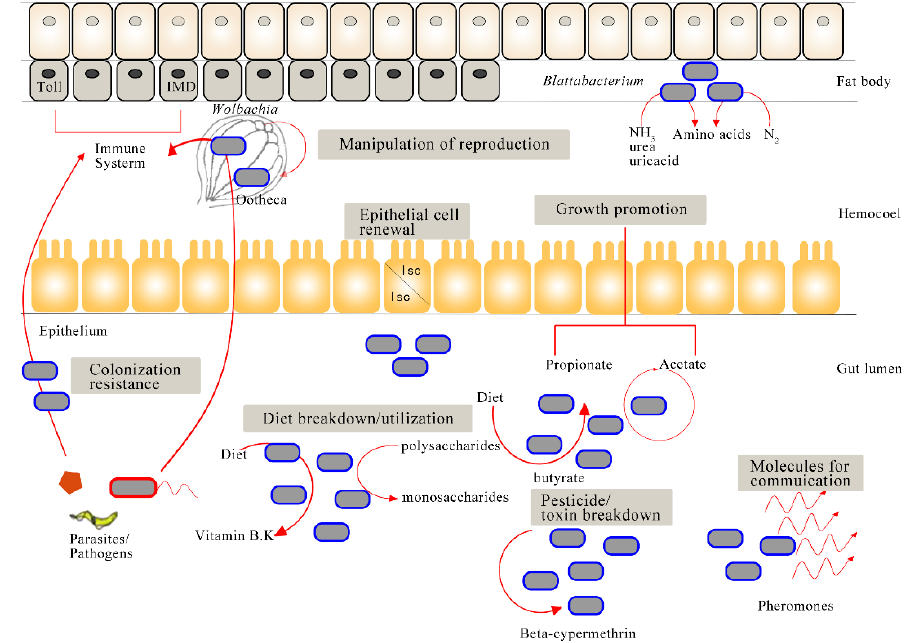
Figure 1. Hypothesized functions of the symbionts of Blattella germanica . The abundant gut symbiotic microbes have been demonstrated to be involved in nutritional physiology, reproductive regulation, pesticide resistance, and immune defense [23]. A prime example for nutritional physiology is that symbionts can be involved in the nitrogen cycle of the host and provide riboflavin and other vitamins, such as Lachnospira in the host’s gut, synthesizing acetate, propionate, and butyrate [32,39]. Moreover, symbionts can activate the immune system of the host to defend against pathogens, such as Pseudomonas and Bacillus , and can strongly inhibit the growth of Beauveria bassiana in vitro [33,40,41]; the endosymbiont Wolbachia might regulate the reproduction of B. germanica [30]. In addition, gut bacteria can synthesize pheromones (e.g., volatile carboxylic acids) or interstitial hormones [42].